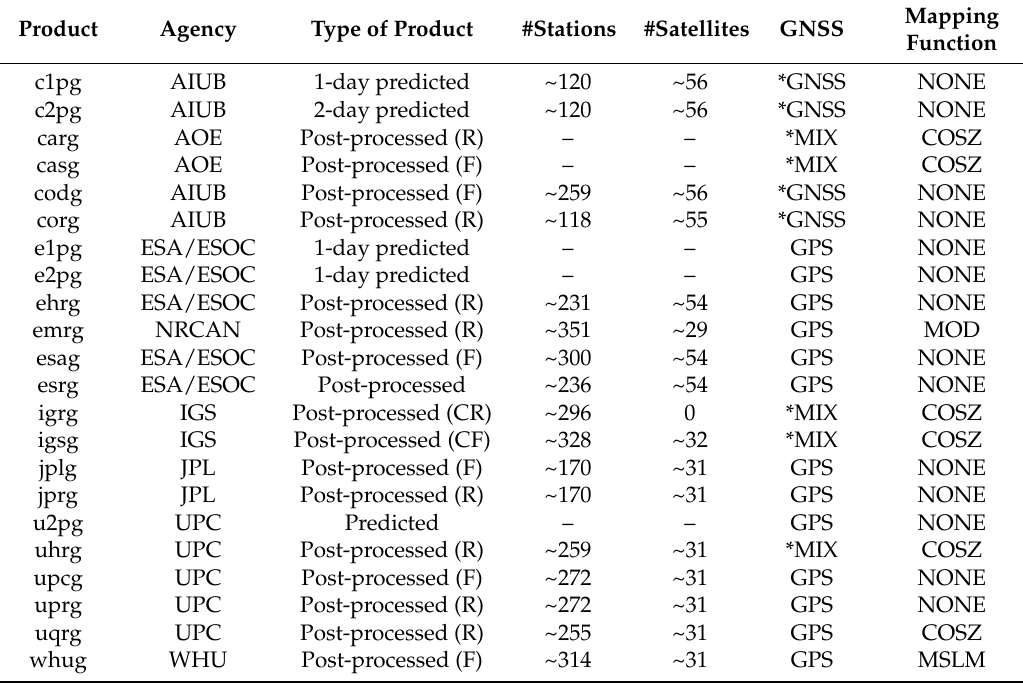
Table 2. Different existing GIM products available to the PPP user from different ACs [33].